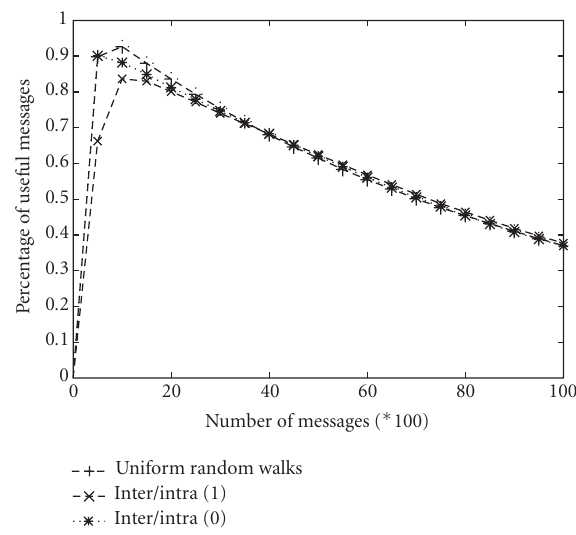
Figure 13: The percentage of messages discovering distinct nodes within a certain message range.